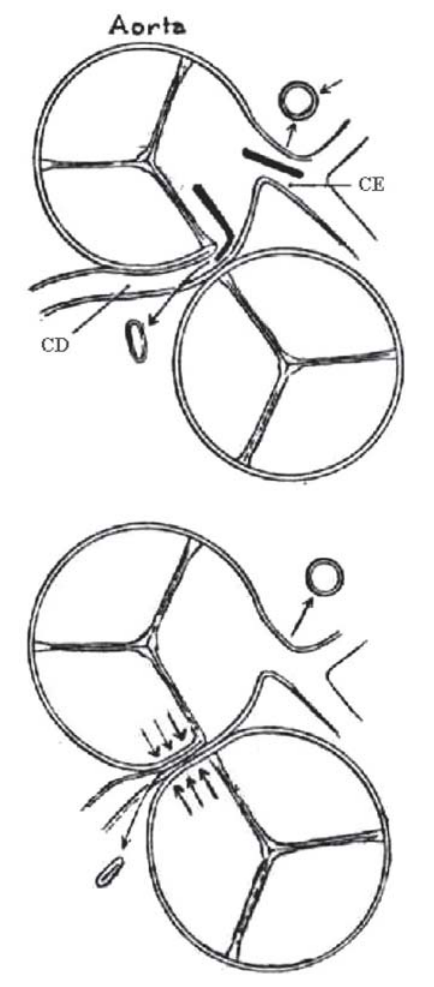
Fig. 2 - Compressão da CD entre aorta e o tronco